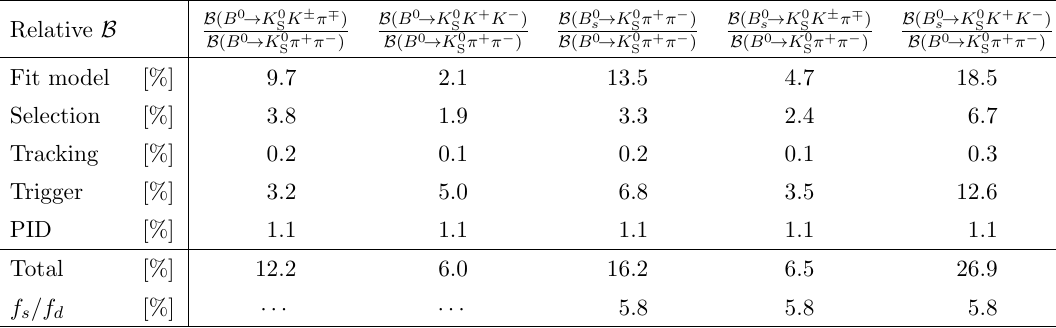
Table 2 . Summary of the systematic uncertainties on the ratio of branching fractions. A weighted average of the two K 0 reconstruction categories and three data-taking periods is performed. The S values quoted for the individual contributions, which are illustrative of the hierarchy between sources of systematic uncertainty, each result from a weighted average in which the other systematic un- certainty contributions are disregarded. The total uncertainty is the weighted average including all contributions. All uncertainties are relative and are quoted as